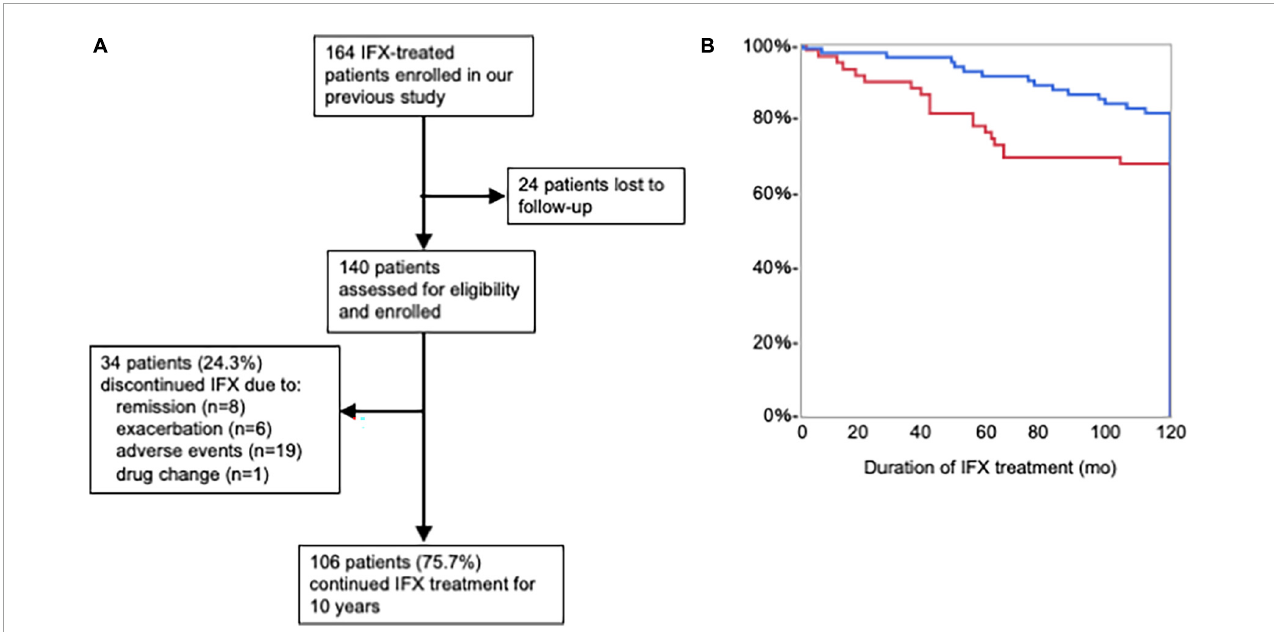
FIGURE1 (A) In a total of 164 infliximab (IFX)-treated BD patients with uveitis, 24 patients were lost to follow-up after the initial study. Of the 140 BD patients included in the present analysis, IFX treatment was discontinued within 10 years in 34 patients (24.3%). One hundred six BD patients continued IFX treatment for more than 10 years, and 10-year IFX continuation rate was 75.7%. (B) The Kaplan–Meier curve of continuation rate of IFX treatment of BD uveitis patients with concomitant agents (red line) and those without concomitant agents (blue line). The IFX continuation rate more than 10 years was significantly higher in BD patients treated with IFX only (81.5%) than in those treated with IFX and concomitant agents (67.8%). log-rank test indicated P < 0.05.